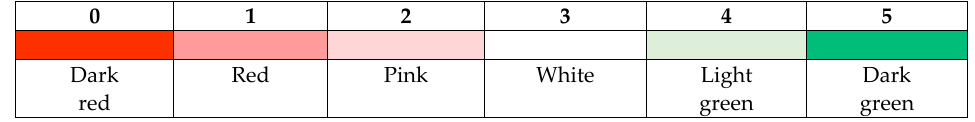
Figure 4. The red-to-green color code for the self-assessment scoring table. The dendrogram of all 205 enterprises is presented on the right in Figure 5. The self- assessment results table for all 205 enterprises, rearranged according to the dendrogram and colored with the red-to-green color code, is presented on the left in Figure 5. Enlarged parts of this picture are presented further in this section—part of the dendrogram representing Cluster A is shown in Figure 6, and part of the table with the individual responses of Cluster A enterprises in shown in Table 5.